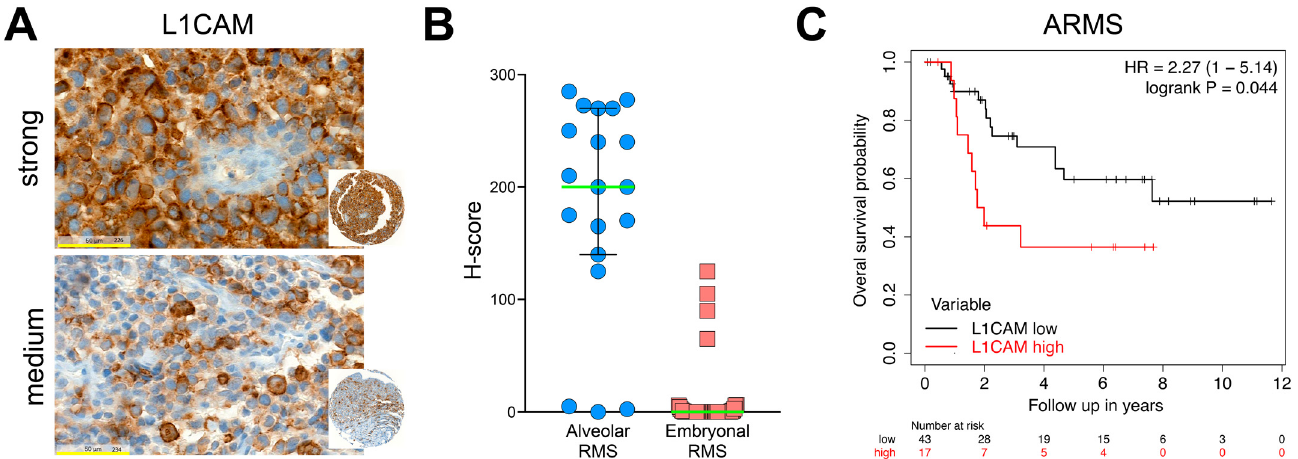
Figure 9. L1CAM is detected in the majority of ARMS cases by IHC, and a high L1CAM mRNA expression correlates with poorer survival. A tissue microarray (TMA) including 24 ARMS and 100 ERMS was stained with L1CAM antibody clone 14.10. ( A ) Upper panel: ARMS sample with strong L1CAM staining, A. lower panel, ARMS sample with medium L1CAM staining. Magnification 40 × , yellow bars represent 50 µ m. ( B ) H-score for L1CAM was calculated by adding the percentage of cells showing strong staining multiplied by 3, to medium staining by 2 and to weak staining. Evaluable tissues: ARMS n = 19, ERMS n = 60. Green bars represent the median value, with a 95% confidence interval. ( C ) Kaplan–Meier survival plot of patients with ARMS comparing high and low L1CAM mRNA expression. Data were obtained from the cohort Davicioni 147 [39] and deposited to the R2: Genomics Analysis and Visualization Platform (http://r2.amc.nl (accessed on 12 January 2023)). Analysis was performed on the ARMS subset using the custom Kaplan–Meier tool (http://kmplot.com (accessed on 14 January 2023)). Shown are the hazard rate (HR) and